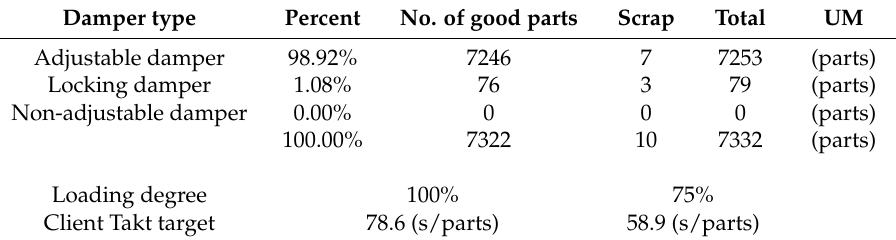
Table 2. Parts and client target takt time for 367 parts/day, measured for 20 days.